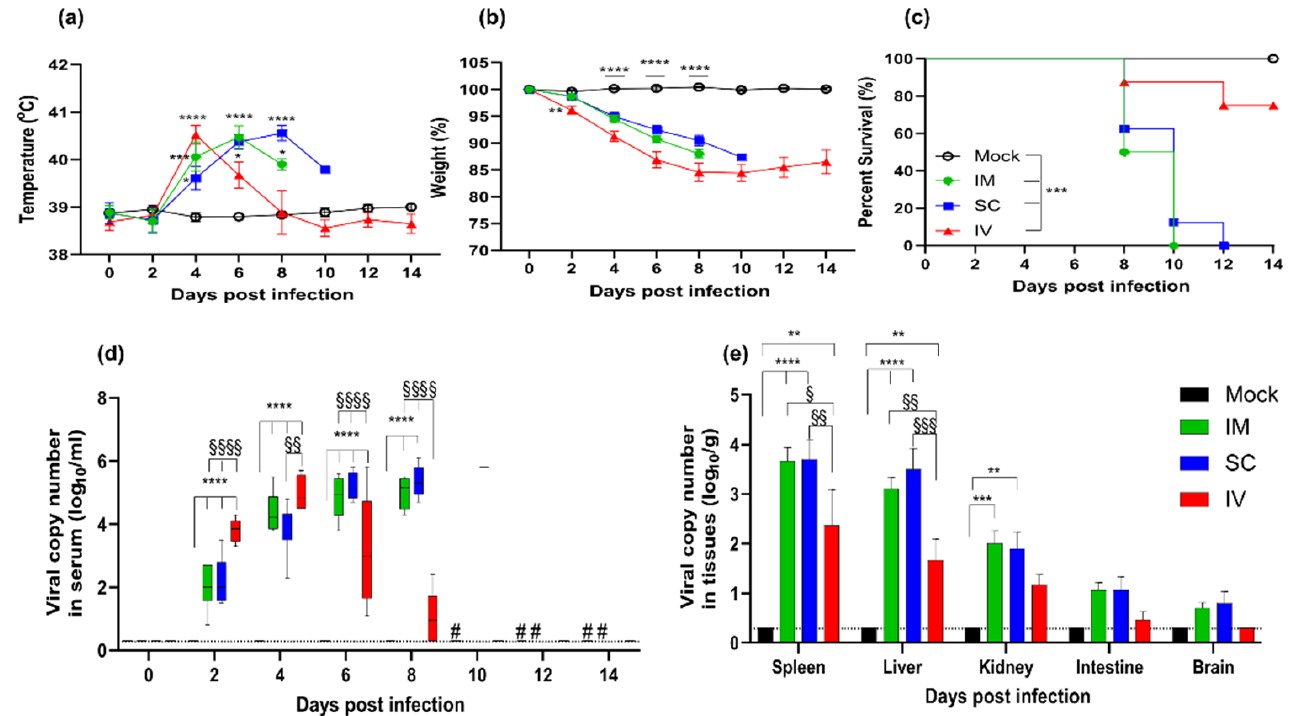
Figure 1. Virulence of severe fever with thrombocytopenia syndrome virus (SFTSV) in aged ferrets